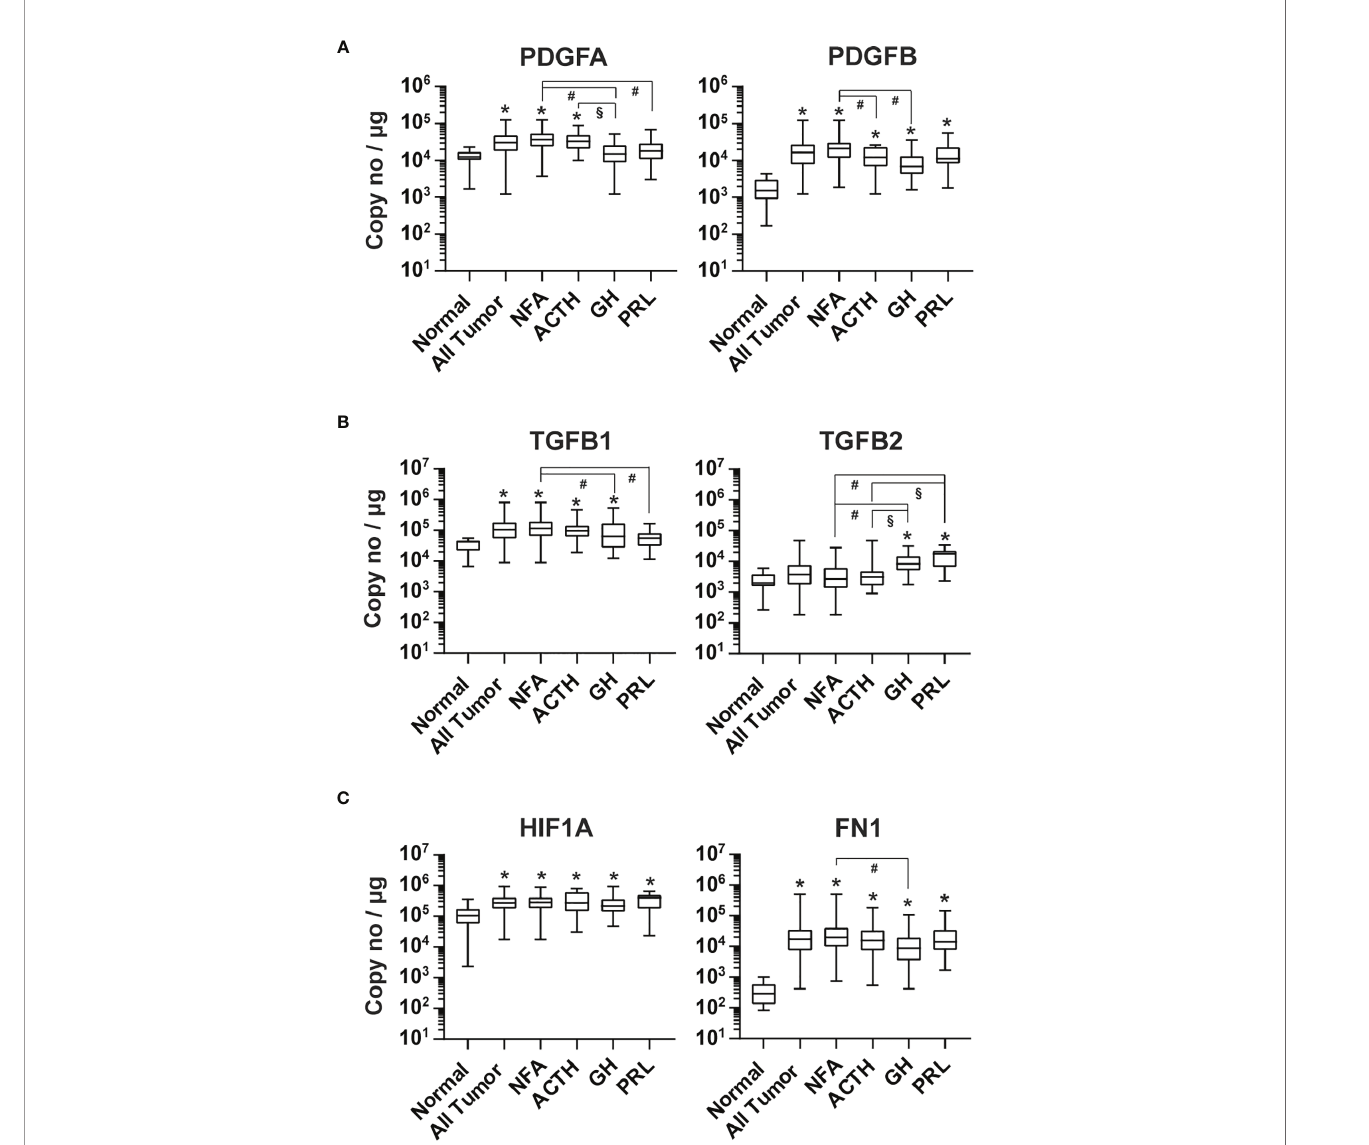
FIGURE 5 | Expression of other angiogenic growth factors in human pituitary tumors. RNA of (A) PDGFA and PDGFB, (B) TGFB1 and TGFB2, and (C) HIF1A and FN1 were quanti fi ed by TaqMan ® probe-based qPCR. Normal pituitary tissue, n = 12; NFA, n = 140; ACTH, n = 16; GH, n = 38; PRL, n = 13. *p < 0.05 vs normal pituitaries; #p < 0.05 vs NFA; §p < 0.05 vs ACTH-producing